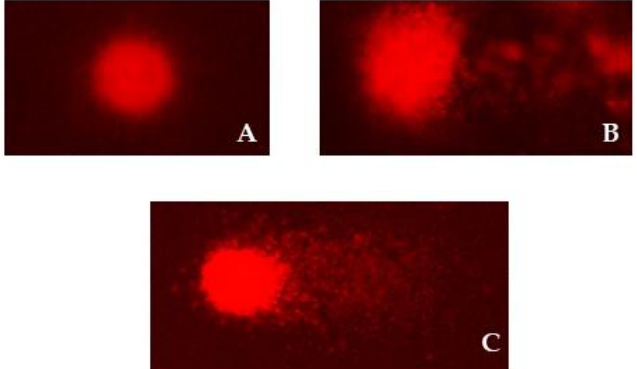
Figure 2. Photomicrographs show nucleoids of HepG2 cells observed in cell cultures after alkaline comet assay procedure: ( A ) Negative control without DNA damage; ( B ) positive control (hydrogen peroxide) with extensive DNA damage; ( C ) damaged DNA after 24 h exposure to leather sample processed with vegetable tanning. The photomicrographs were acquired using Comet Assay IV TM image analysis software (Instem-Perceptive Instruments Ltd., Suffolk, Halstead, UK) at a magnification of 200 × . Further evaluations of DNA damage included analysis of the frequency distribution of comets measured in treated and control cells (Figure 3). The Y-axis represents the num- ber of comets belonging to a particular category in relation to four quartiles: <25th percen- tile, 25th – 50th percentile, 50th – 75th percentile and >75th percentile. The differences be- tween the treated cells and the control were tested using Pearson ’ s χ 2 test, and the statis- tically significant differences compared with the negative control are shown in the above figure. The pattern of DNA damage measured in HepG2 cells after exposure to the tested samples of leather shows that for both comet descriptors (%DNA in tail and tail length), the proportion of comets belonging to the <25th percentile decreased significantly com- pared to the untreated cells, while the proportion of those belonging to the 75th percentile decreased significantly. Although there were some minor variations in the percentages of comets belonging to a particular category with respect to the four quartiles, none of the differences observed after exposure to the leather sample obtained by chrome tanning (label CHR-T2) was statistically significant compared to the negative control.